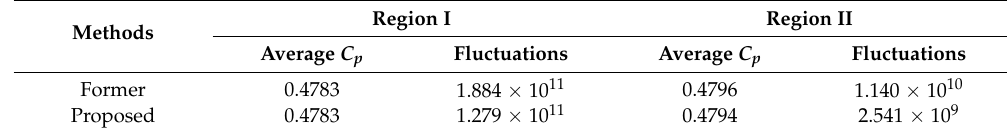
Table 1. Statistics of efficiency and fluctuations.